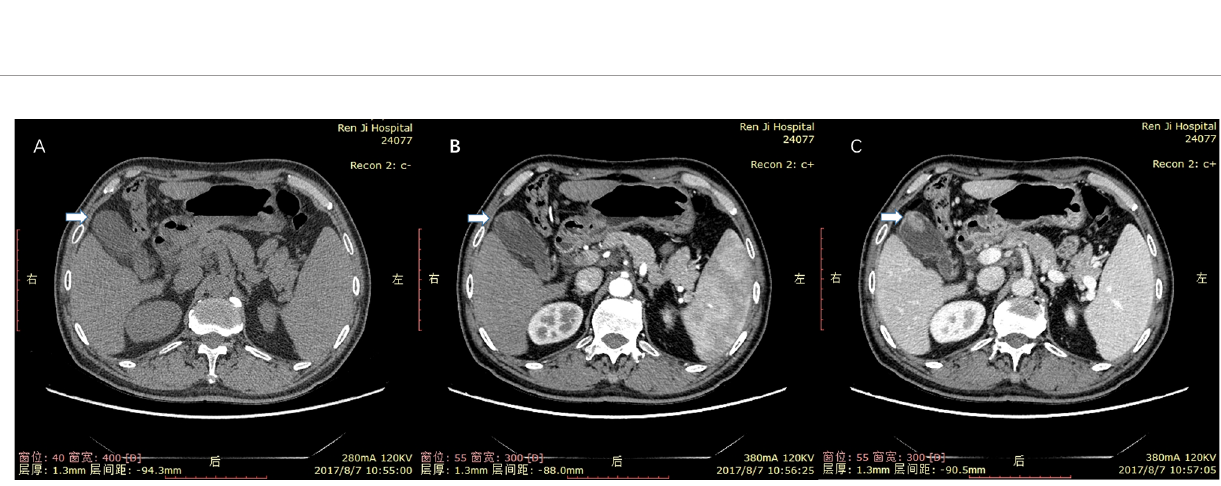
FIGURE 6 | Cholesterol polyp measuring 21 mm in diameter in a 66-year-old man. (A) nonenhanced phase. (B) arterial phase. (C) portal venous phase. The mass could be clearly detected in the in arterial and portal venous phase. It did not have delayed enhancement characteristics of non-neoplastic polyps. So it was mistaken as gallbladder